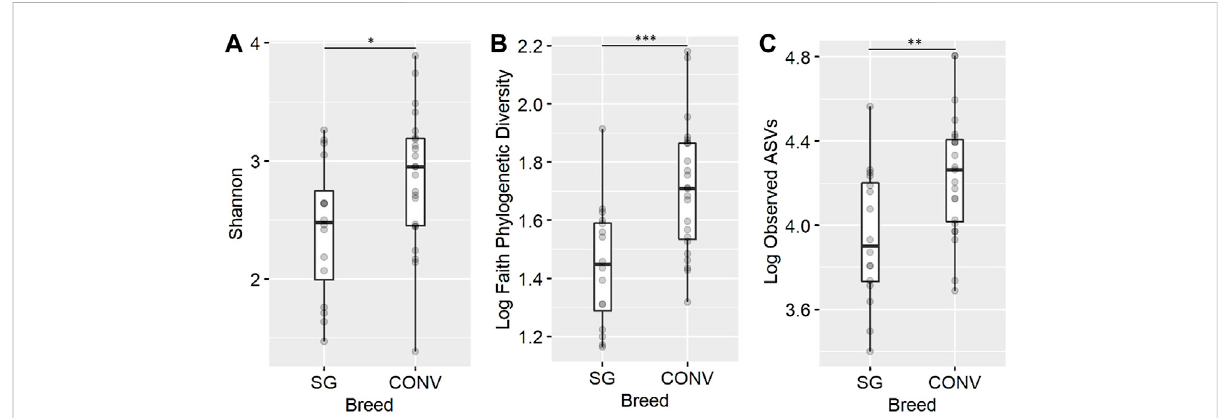
FIGURE 2 TheeffectofgeneticlineontheilealShannondiversity (A) ,Faithphylogeneticdiversity (B) ,andobservedASVrichness (C) for7-day-oldbroilers. The presence of an asterisk indicates asigni fi cant difference between breeds in which * correspondsto p < 0.05, ** correspondsto p < 0.01, and *** corresponds to p < 0.001. Conventional (CONV) and slow-growing (SG) broilers.